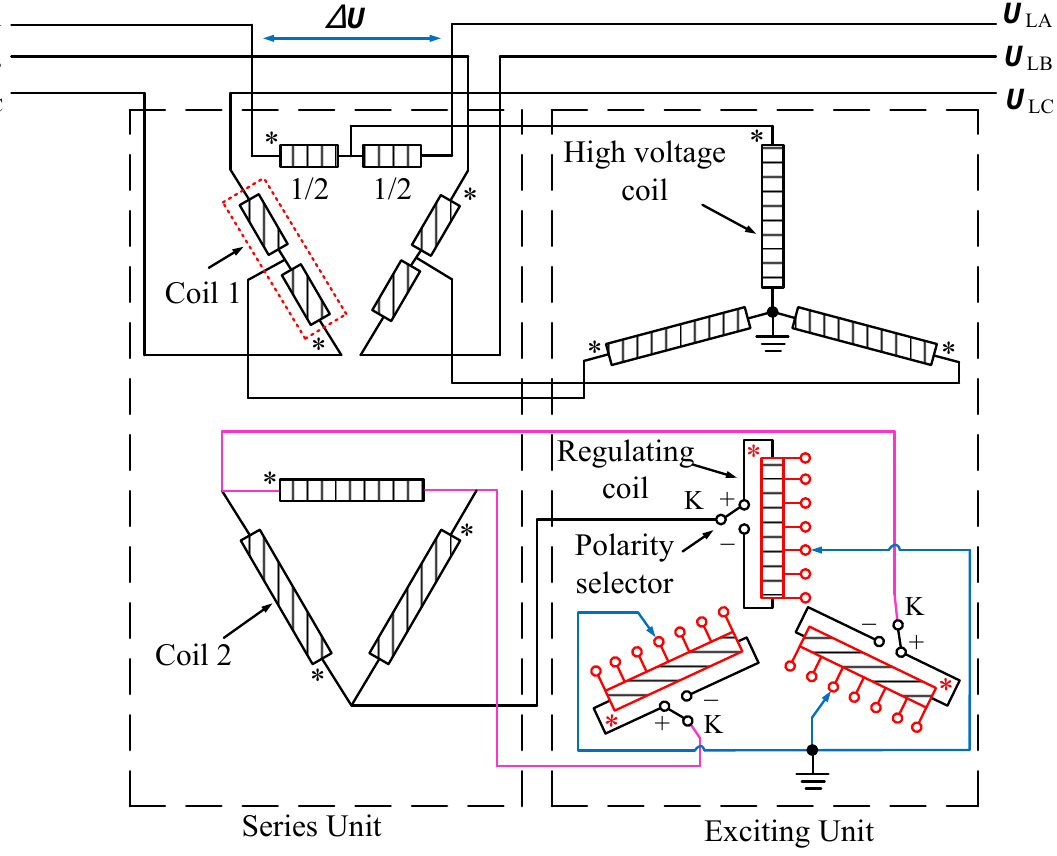
Figure 5. Topological structure of double core symmetrical.